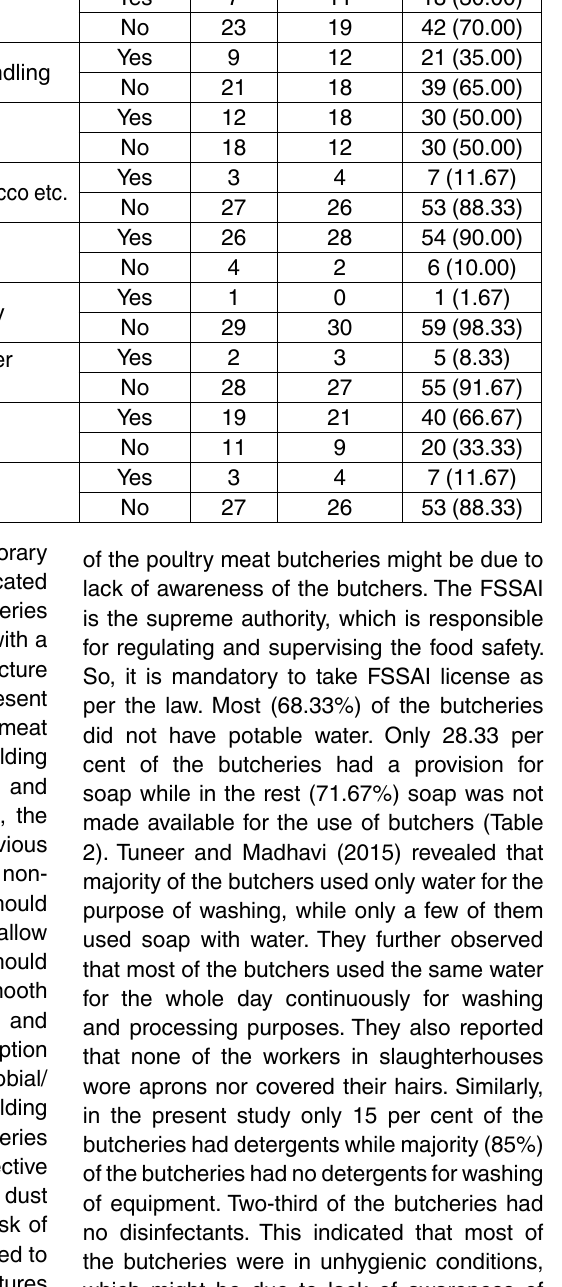
table 3. Distribution of respondents based on their personal hygiene at the meat shop Attributes Wore clean cloth Wore face mask/Head gear/ Hand Gloves/Aprons Wore rings Washed hands before and after meat handling Washed hands after nose blowing Washed hands after smoking, chewing tobacco etc. Washed hands after visiting